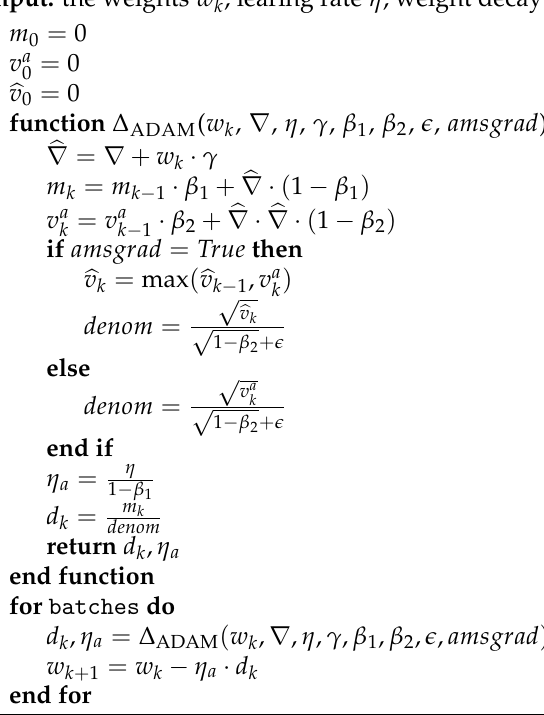
Algorithm 2 ADAptive Moment estimation